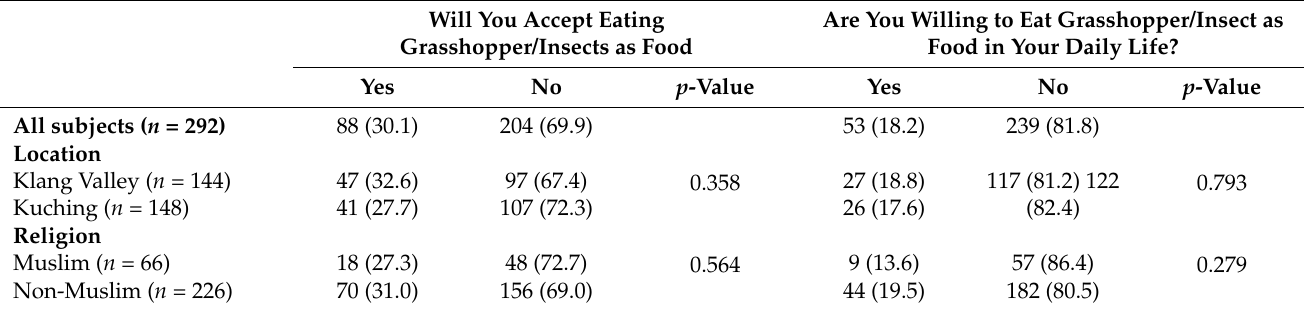
Table 3. Acceptance of grasshoppers and other insects as food based on location and religion, n (%). Will You Accept Eating Are You Willing to Eat Grasshopper/Insect as Grasshopper/Insects as Food Food in Your Daily